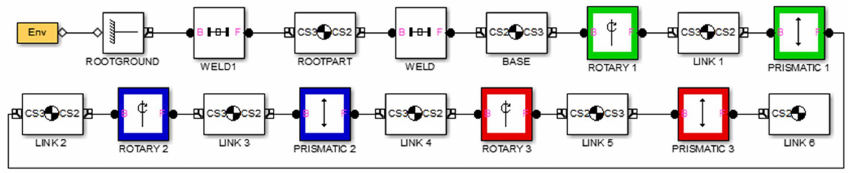
Figure 5. Basic simulation circuit for the 6-DoF redundant planar manipulator robot.